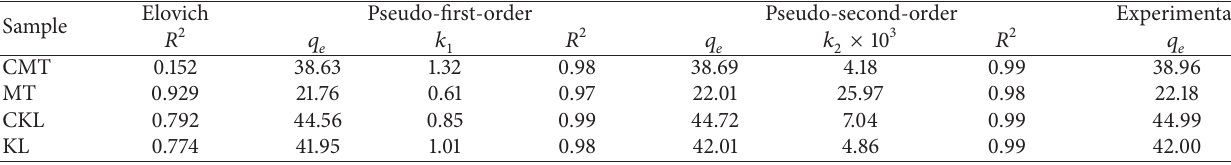
Table 2: The coefficients of the kinetic models for sorption of pyrene at 298 K.